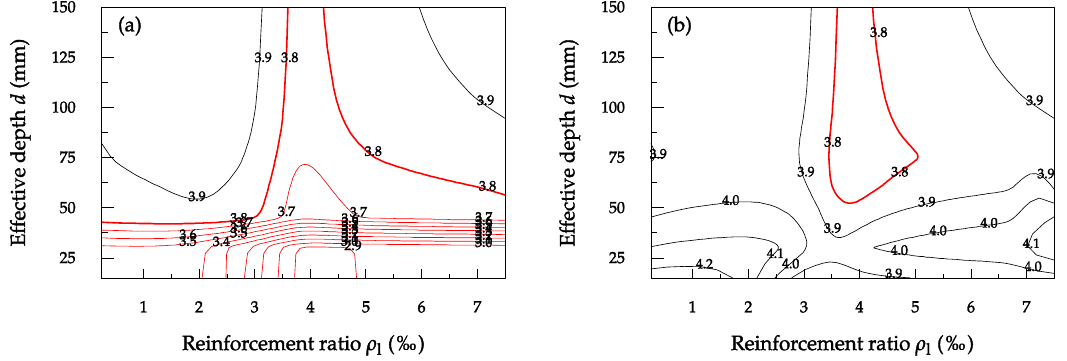
Figure 15. Reliability indices for ( a ) γ T = 1.3 and γ C = 1.5; ( b ) γ T = 1.3, γ C = 1.5 and d eff.